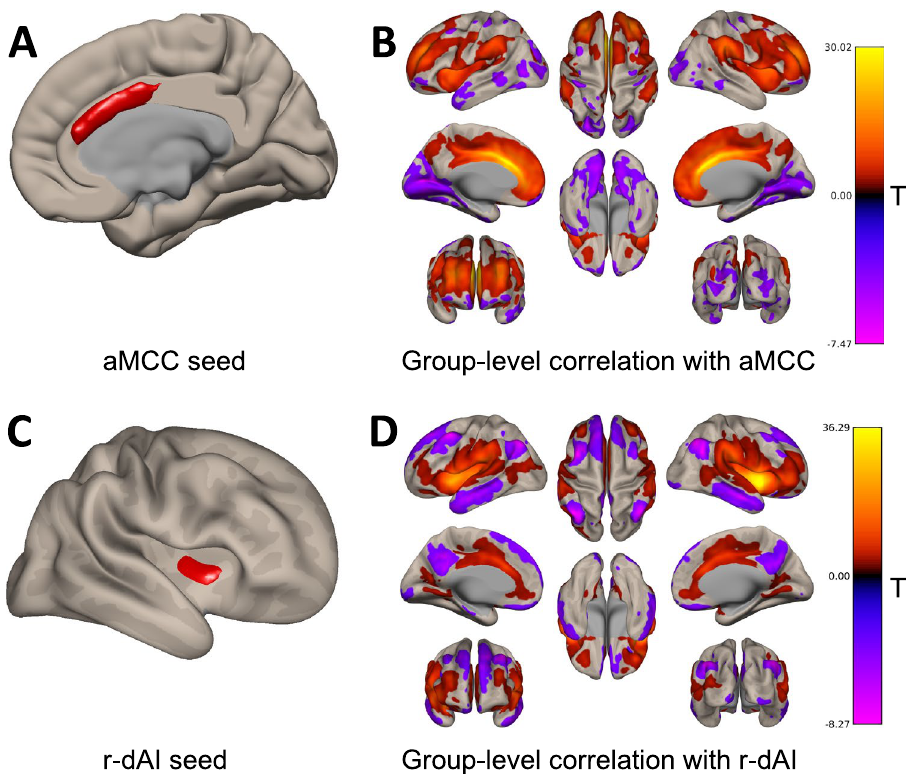
Figure 1. ( A ) Illustrates the aMCC seed region. ( B ) Summary figure of the whole group-level connectivity with the aMCC seed ROI showing functional connectivity with regions of the salience network (e.g. anterior insula, temporoparietal junction). ( C ) Illustrates the r-dAI seed region. ( D ) Summary figure of the whole-group-level connectivity with the r-dAI seed ROI demonstrating our seed functionally connected to the salience network (bilateral insula, temporoparietal junction, inferior frontal operculum, anterior cingulate cortex), and was anticorrelated with the default mode network (inferior parietal lobule, precuneus, superior frontal gyrus). All second-level contrasts assessing the association with behavioral variables of interest take the average BOLD signal within the seed region only and correlate that with all other voxel in the brain